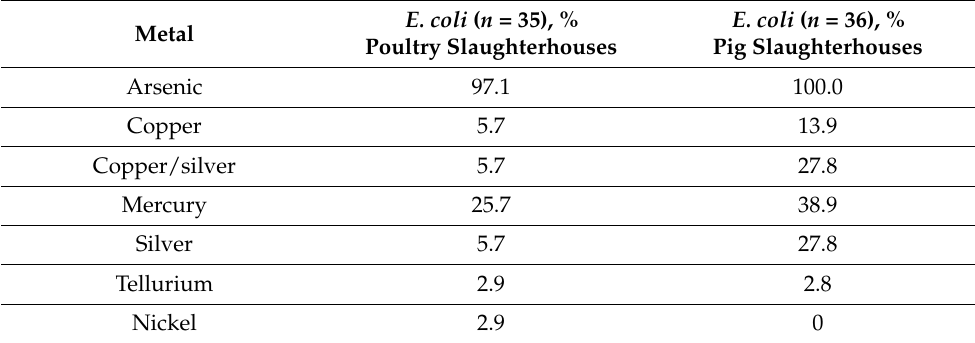
Table 4. Heavy metal resistance genes detected in E. coli isolates recovered from wastewater and process waters from poultry and pig